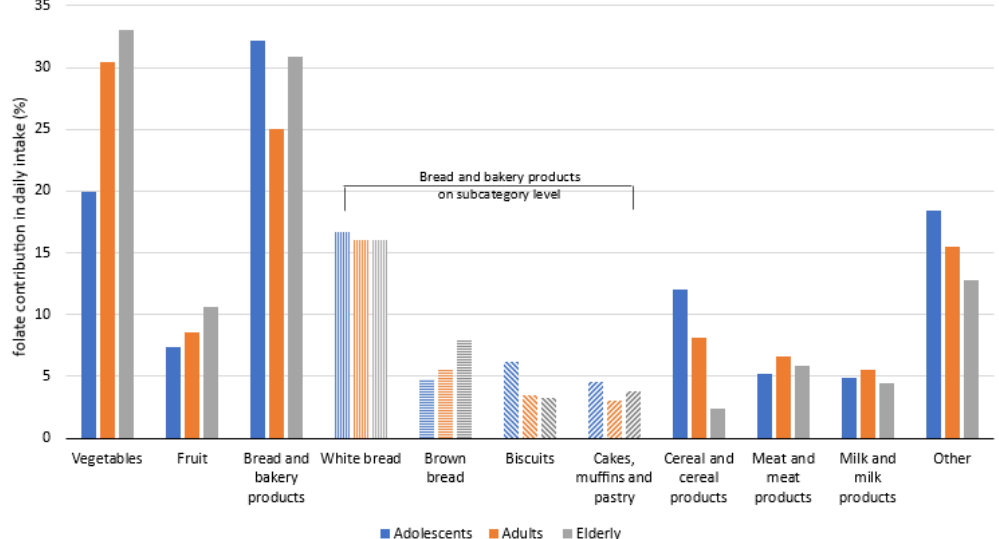
Figure 2. Relative contribution of selected food categories to daily folate intake among all three age cohorts (% of total folate intake; adolescents: 10–17 years; Adults: 18–64 years; Elderly: 65–74 years).